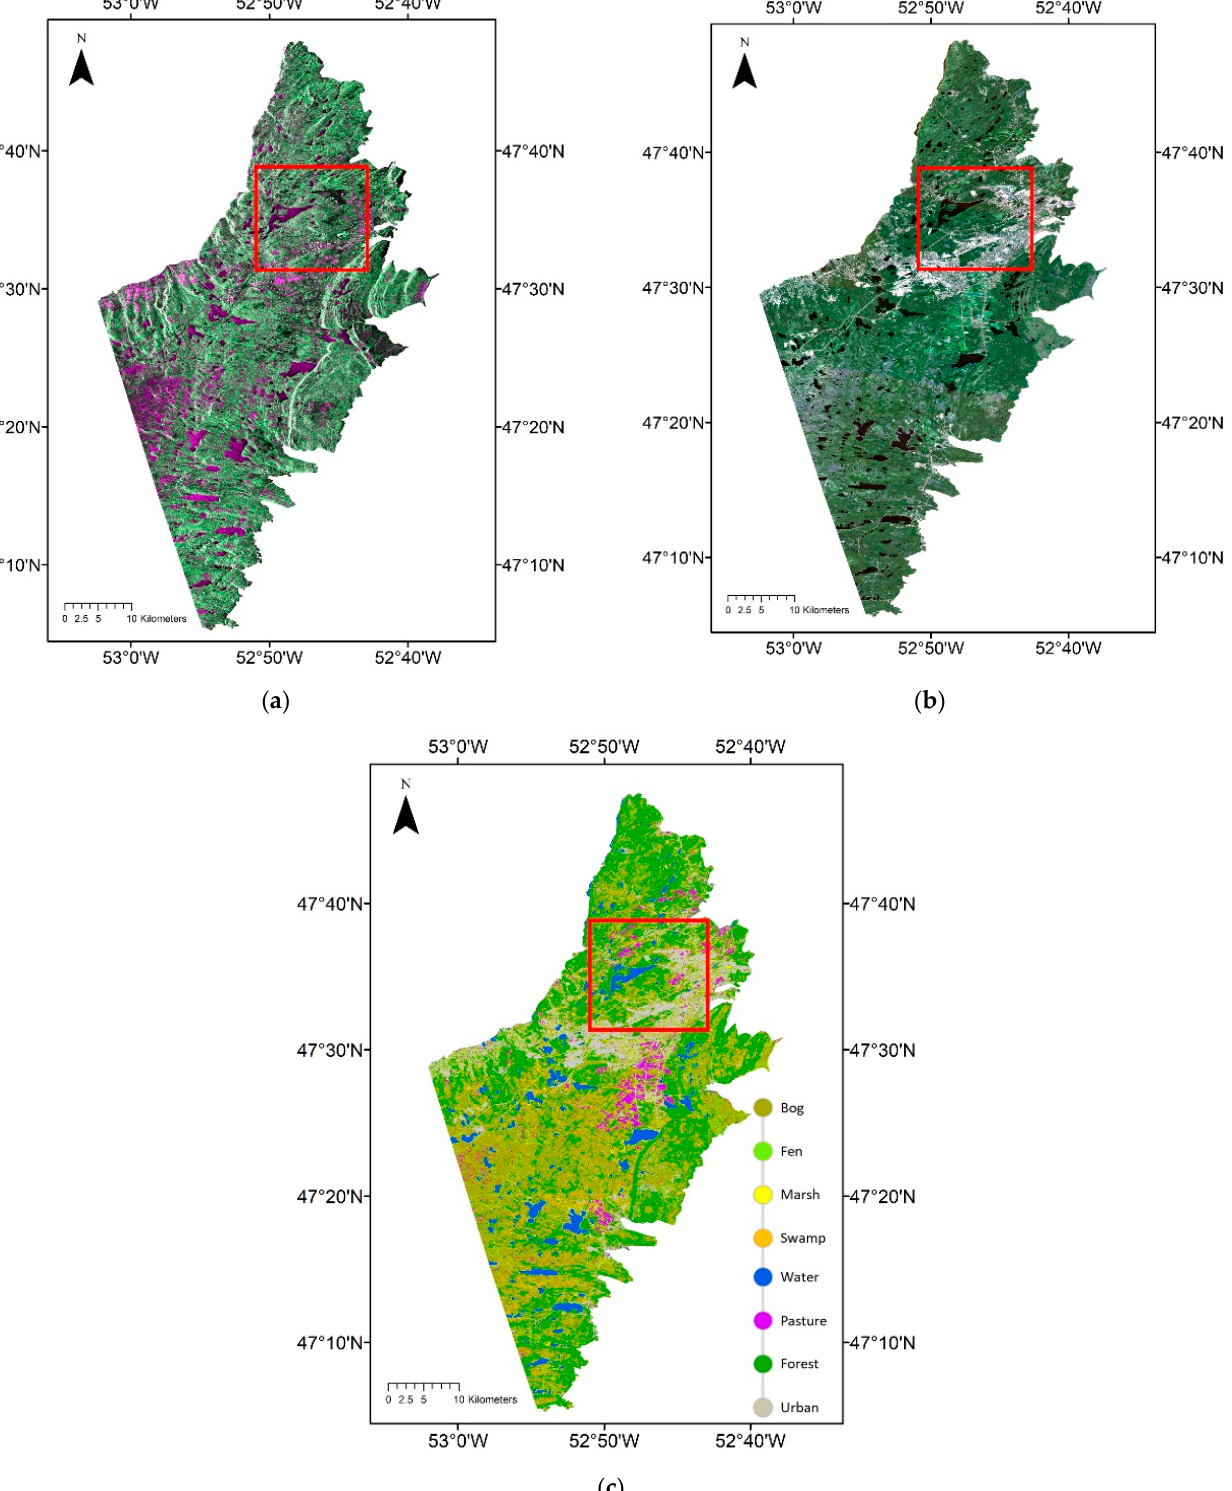
Figure 6. ( a ) Color composites of RCM data (R: VV, G: VH, B: VH/VV) ( b ) True color composite of Sentinel-2 imagery, and ( c ) Classification map of the study area, discriminating eight land cover classes. Red frame indicates a selected zoom-in area in Figure 7.